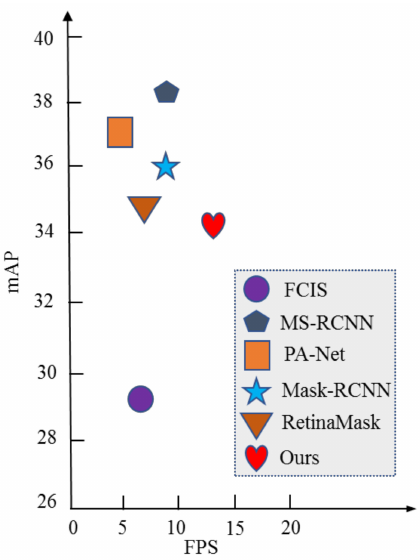
Figure 8. Performance and real-time performance comparison of segmentation algorithms for each instance on coco